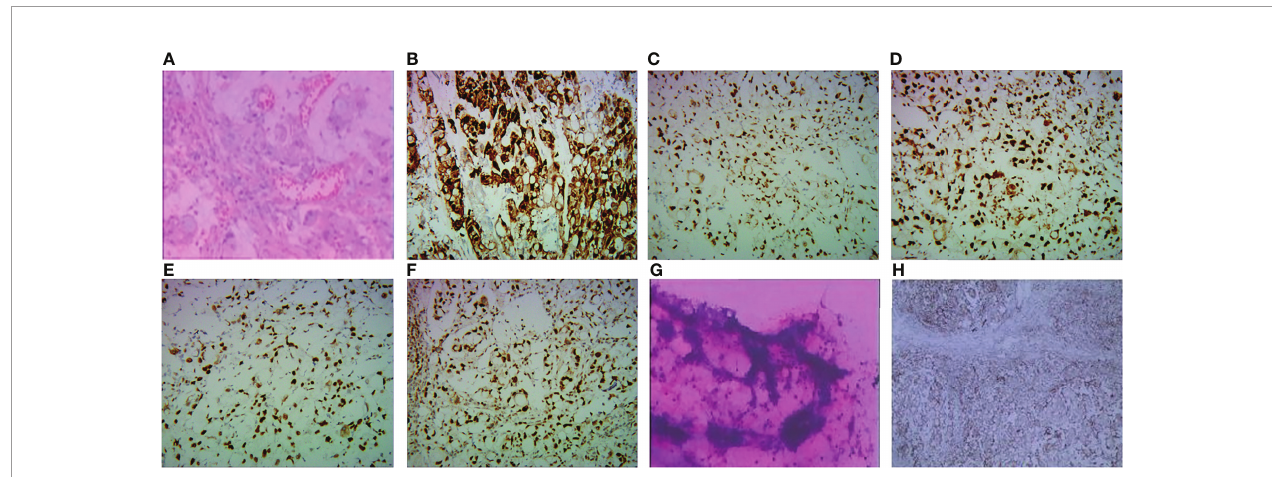
FIGURE 1 | (A – F, H) Pathological and immunohistochemical staining of gastric cancer biopsy specimens from this patient. (A) Gastric adenocarcinoma (hematoxylin and eosin). (B) The tumor cells were strongly positive (3+) for HER2/neu immunostain. The expression of MLHI (C) , MSH2 (D) , MSH6 (E) , and PMS2 (F) was preserved in tumor cells. (G) There were no tumor cells in the pelvic effusion. (H) showed positivity for PD-LI CPS